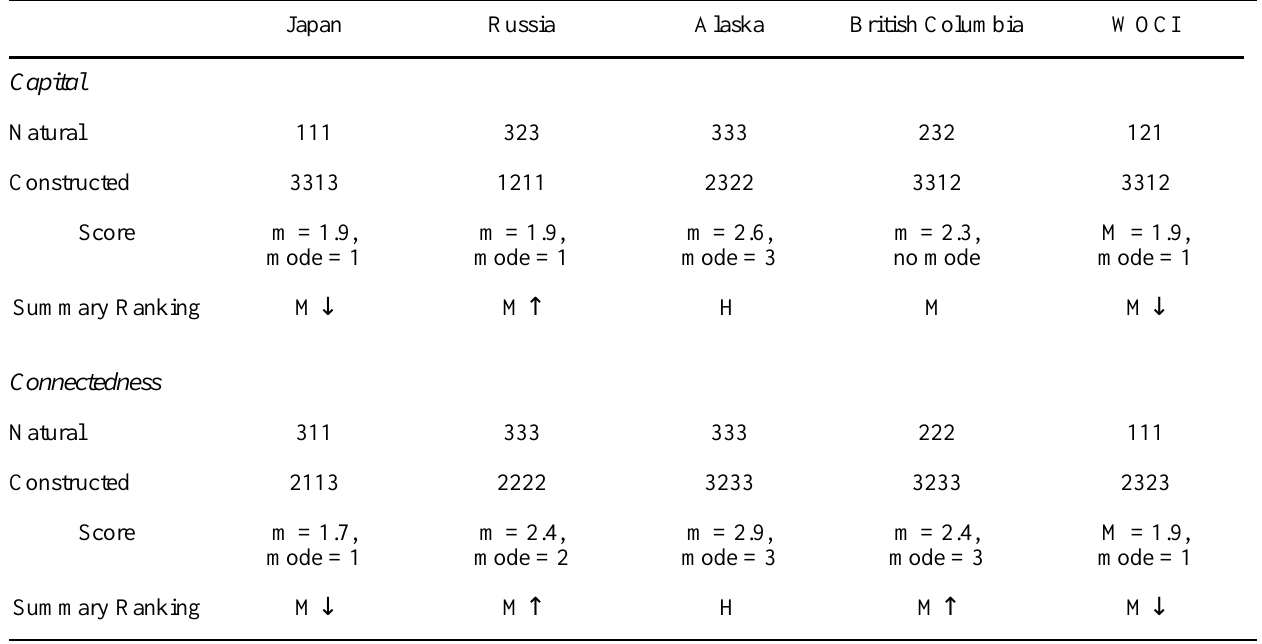
Table 4. Tabulated numerical scores for the five regional capital accumulation and connectedness scores (L = 1, M = 2, H = 3). Summary rankings are based on the mean, whereas trend is indicated by the